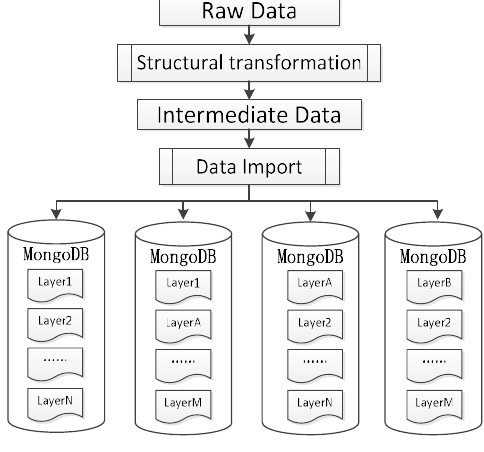
Figure 1. The process for vector data store